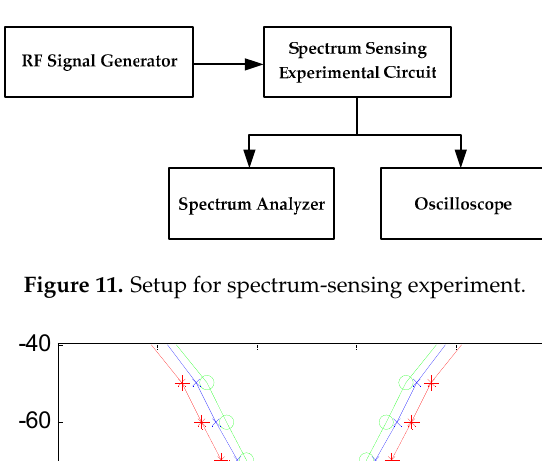
Figure 10. Experimental spectrum-sensing circuit based on a unidirectionally coupled, overdamped nonlinear oscillator.